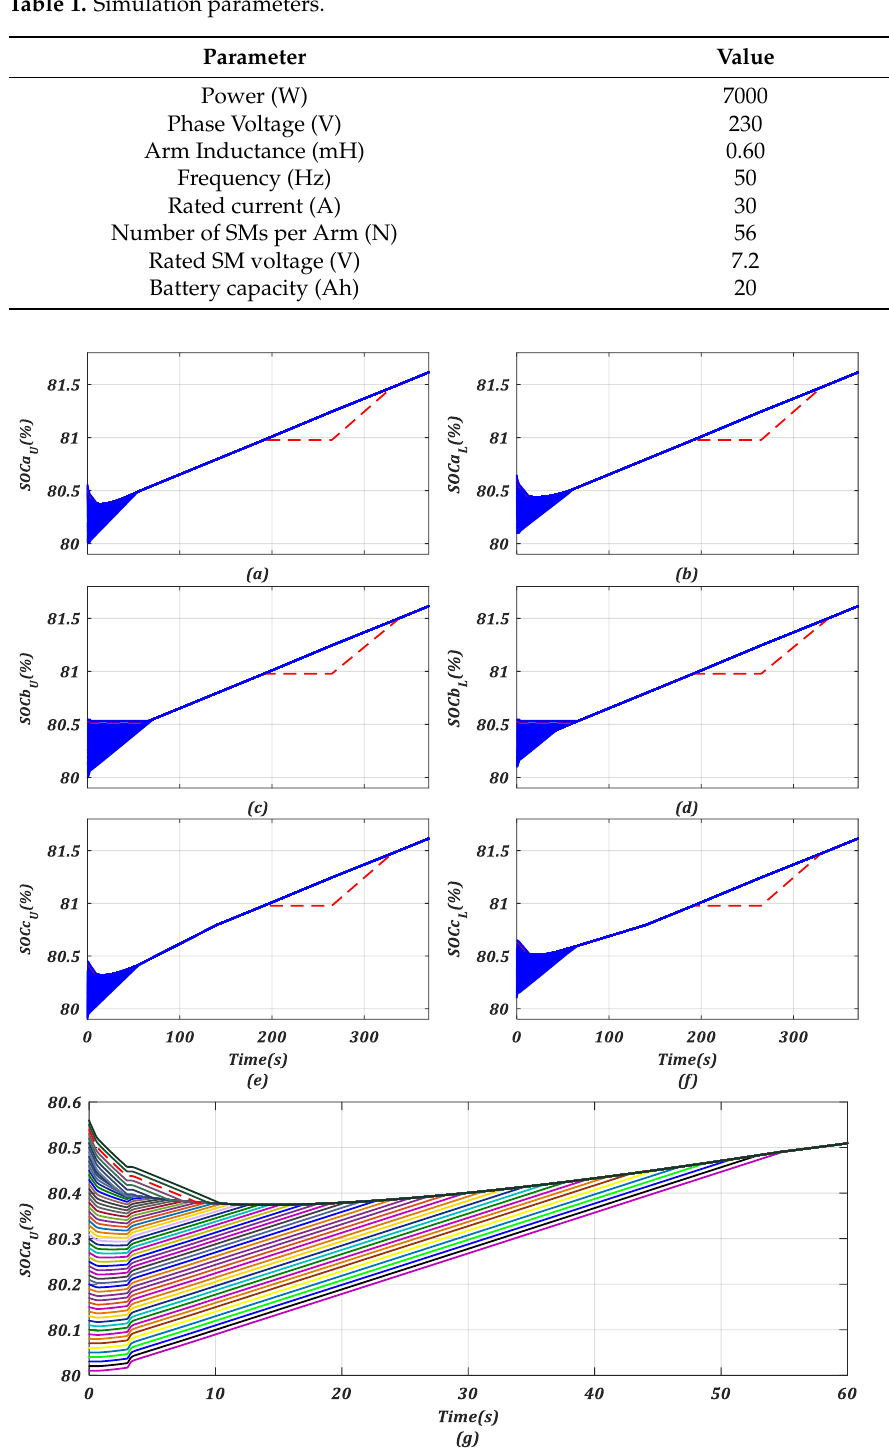
Figure 7. SOC of individual batteries in the converter arms showing the overridden battery in each arm (dashed red line): ( a ) upper arm in phase A; ( b ) lower arm in phase A; ( c ) upper arm in phase B; ( d ) lower arm in phase B; ( e ) upper arm in phase C; ( f ) lower arm in phase C; ( g ) phase A upper arm during equalisation period.